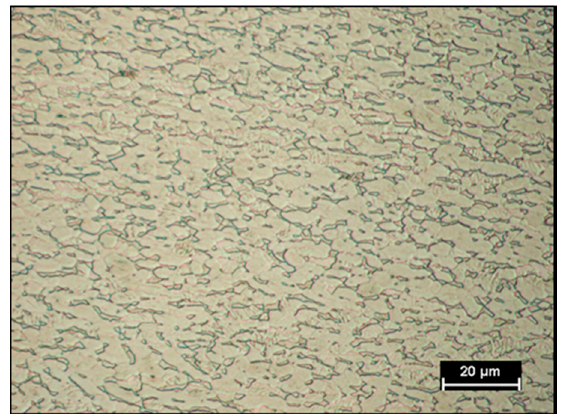
Figure 3. AA6061 as-received microstructure.